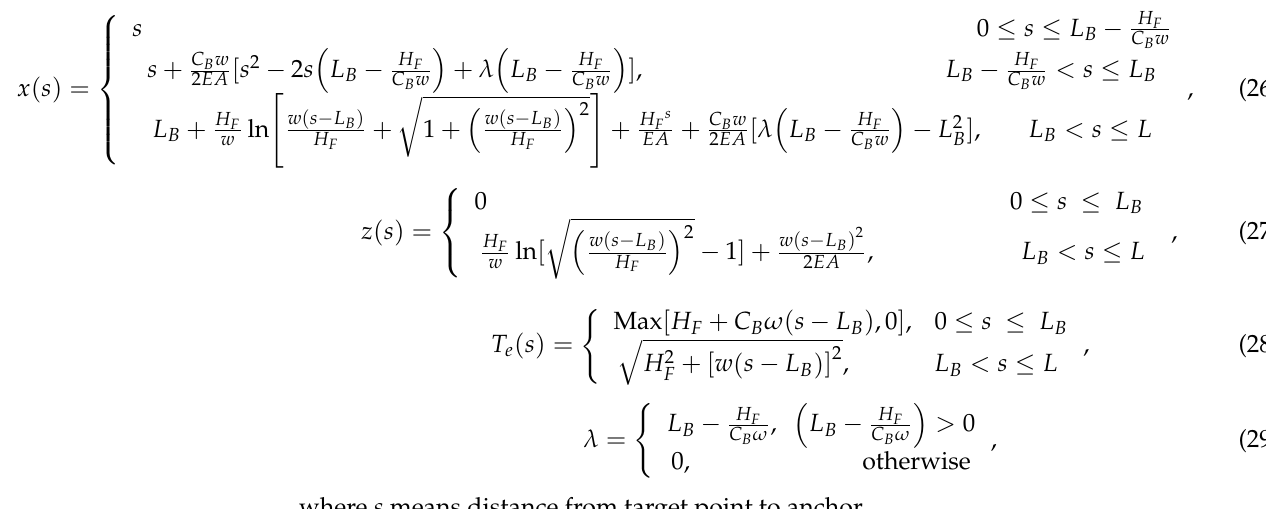
Figure 2. Schematic of mooring system with one mooring line. Then, deformation and tension of the entire mooring line can be calculated further. For any point on the mooring line, its horizontal and vertical distances to anchor are labeled as x and z , respectively; meanwhile, mooring tension at a specified point is labeled as T e . They can be computed, respectively,